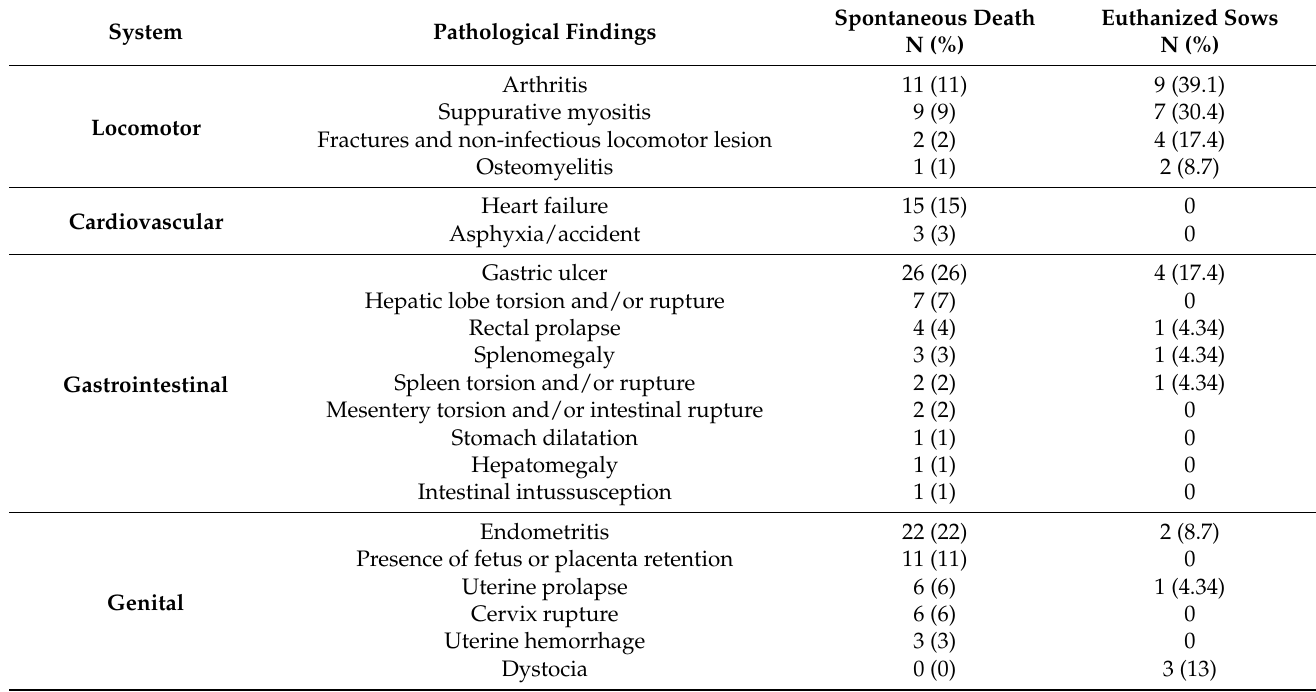
Table 2. Post-mortem findings in spontaneous death and euthanized